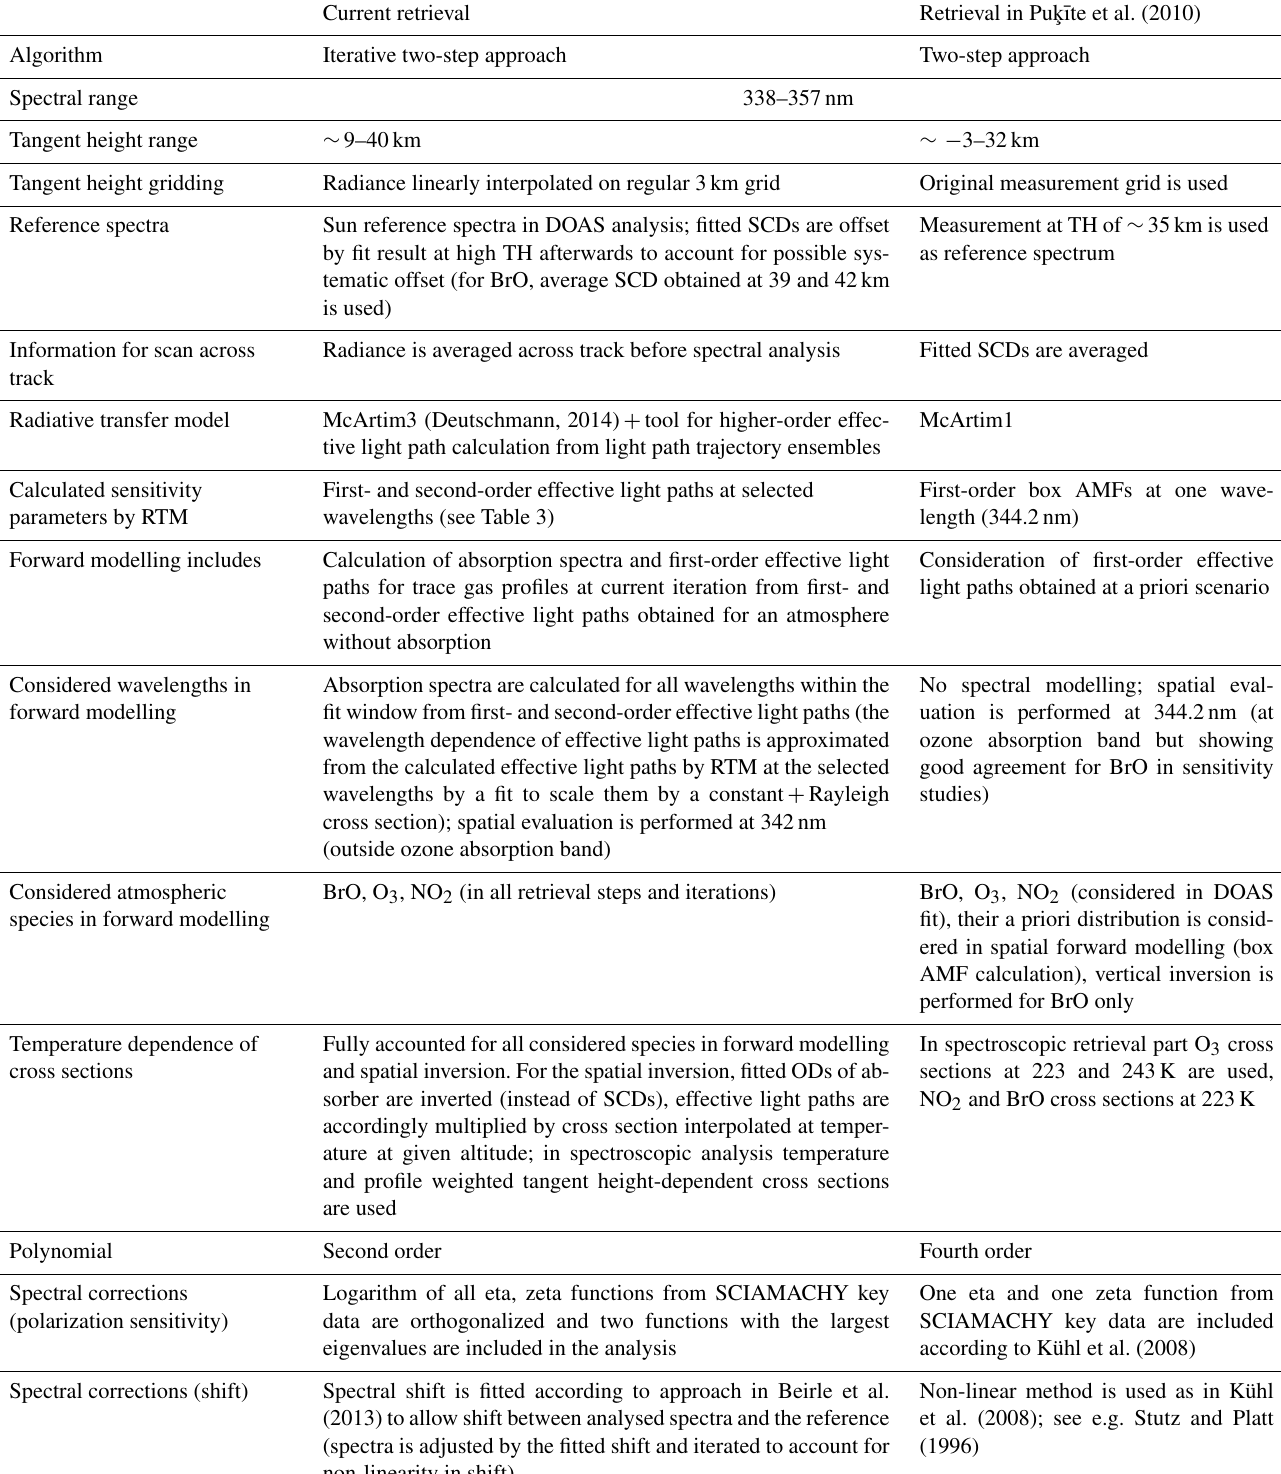
Table 4. Comparison of the current retrieval algorithm implementation for BrO with the algorithm in Puk¸¯ıte et al.